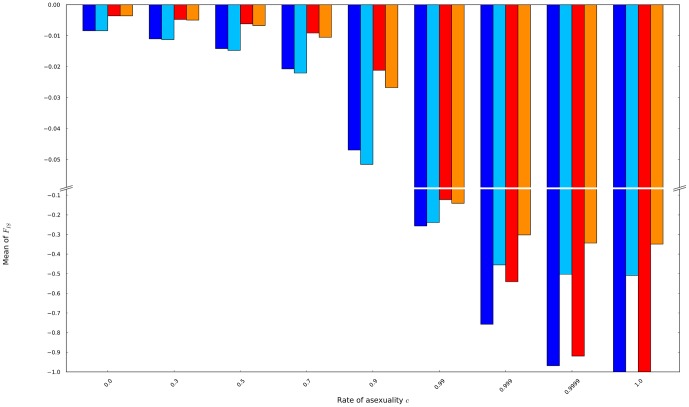
The means of the possible distributions of F
IS were obtained from populations of 60 individuals mutating at a rate of 10−8 (dark blue) and 10−3 (light blue), and from populations of 140 individuals mutating at a rate of 10−8 (red) and 10−3 (orange).